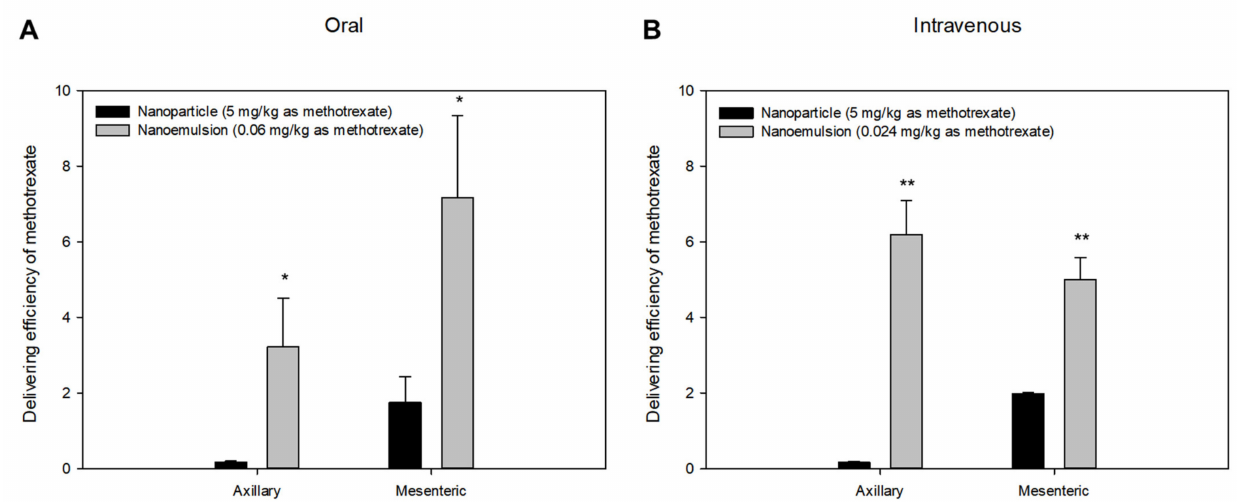
Figure 5. Mean delivering efficiencies of methotrexate to axillary and mesenteric lymph nodes at 2.5 h after oral ( A ) or intravenous ( B ) administration of methotrexate-loaded nanoparticles (- • -, 5 mg/kg as methotrexate) and methotrexate- loaded nanoemulsions (- -, 0.06 or 0.024 mg/kg as methotrexate) in rats. Vertical bars represent standard deviation of (cid:35) the mean ( n = 5). Delivering efficiency in each tissue was calculated as the ratio of the concentration in the tissues to the concentration in plasma. * p < 0.05 compared with the oral administration of nanoparticle. ** p < 0.05 compared with the intravenous administration of